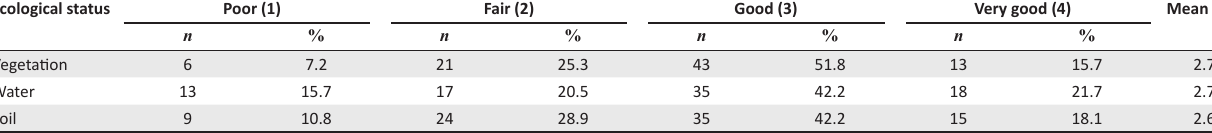
TABLE 5: The ecological status of the key components of wetlands by private wetland owners. Ecological status